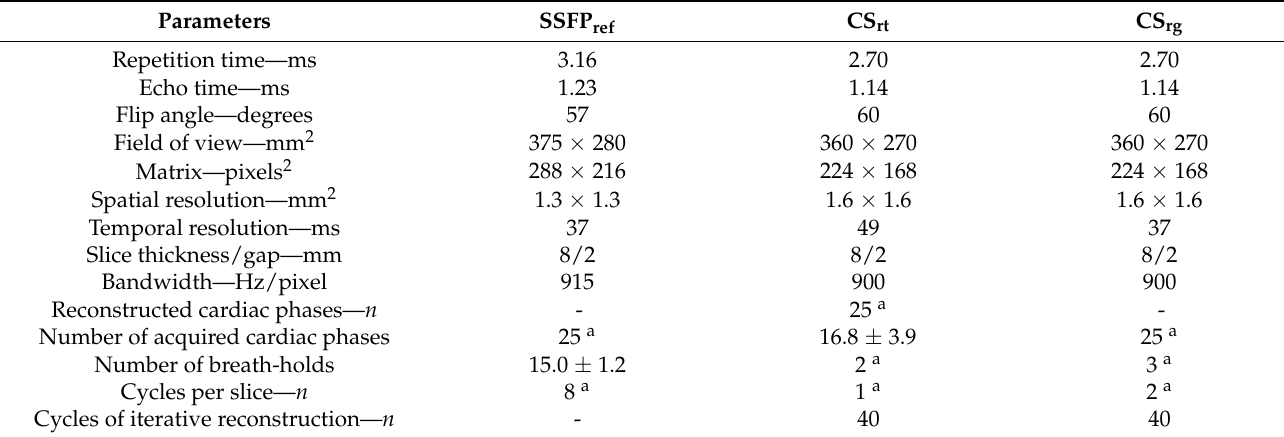
Table 1. Imaging parameters of the reference steady-state free precession cine, real-time compressed sensing cine and segmented retrogated compressed sensing cine.